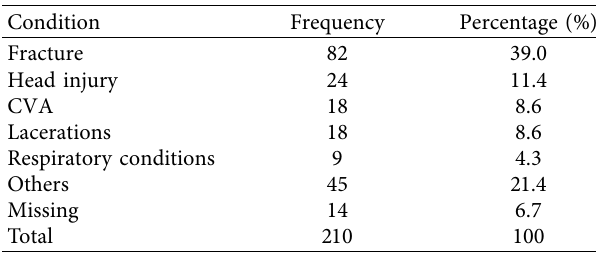
Table 3: Common conditions for which DAMA was